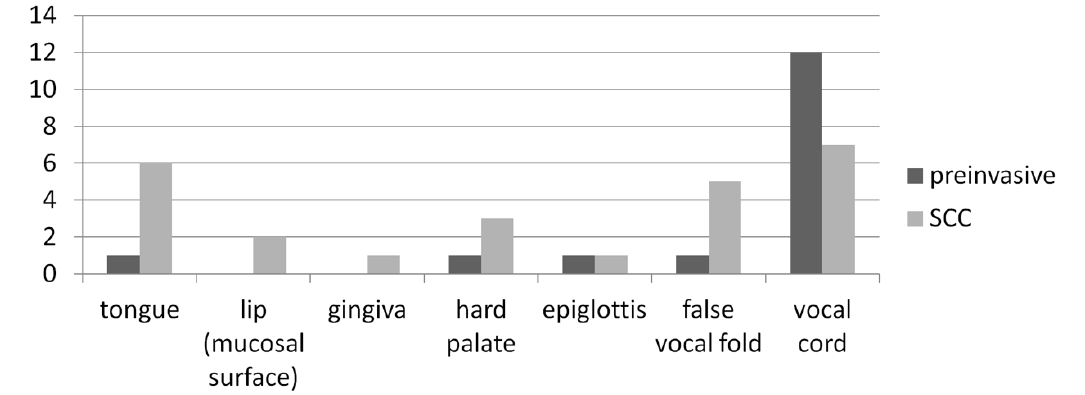
Figure 1. Sites of the lesions and their histological classification.